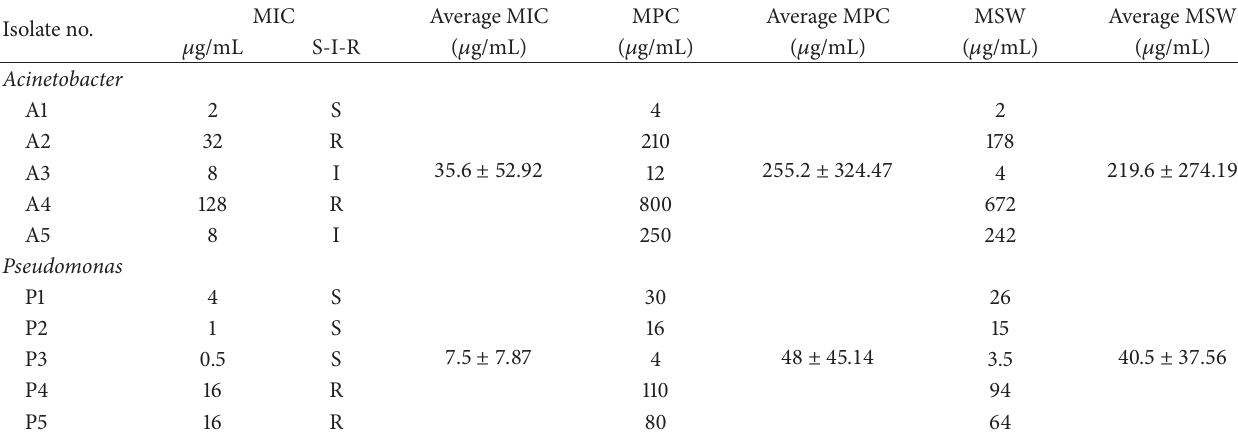
Table 4: Determination of MIC, MPC, and MSW using Imipenem.